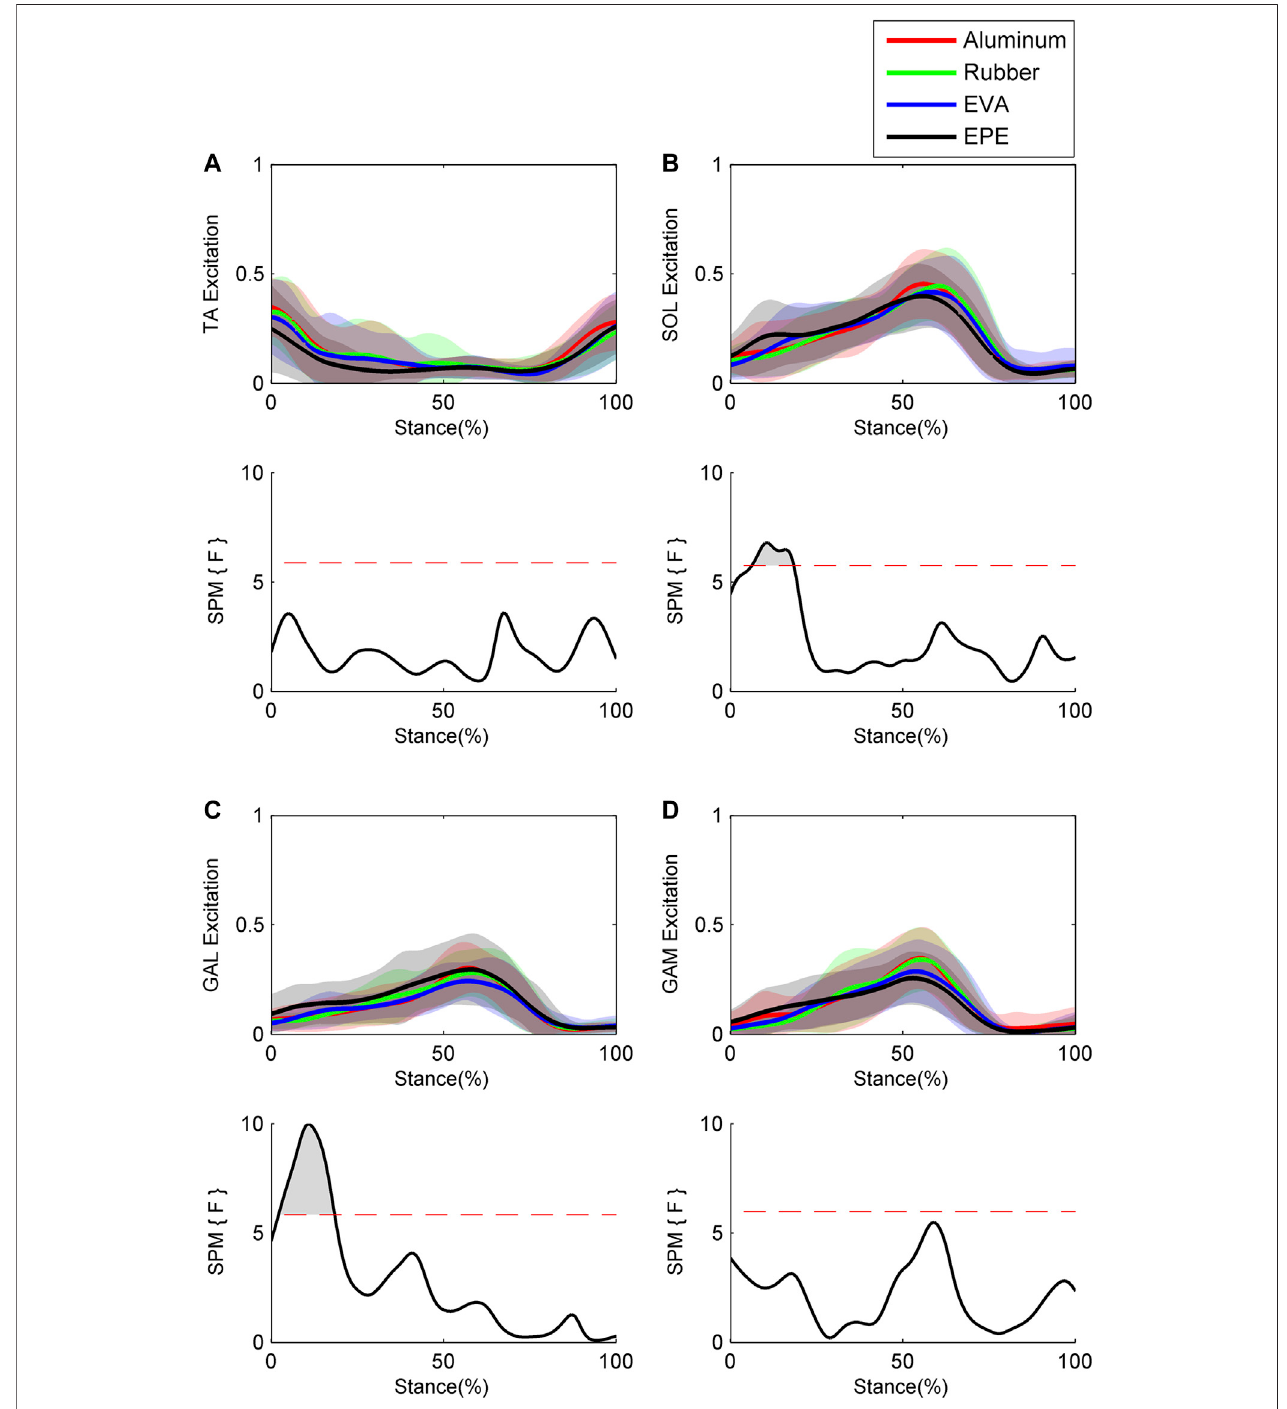
FIGURE 5 | Ensemble average curves (continuous line) and standard deviation (shaded area) for muscle excitation during walking: (A) tibialis anterior (TA); (B) soleus(SOL); (C) gastrocnemius lateralis (GAL); and (D) gastrocnemius medialis (GAM). Data are reported for the stance phase ofwalking with0% being heelstrike and 100% being toe-off events. The shaded areas in the SPM fi gure indicate that a signi fi cant difference was found ( p < 0.05) during this period.